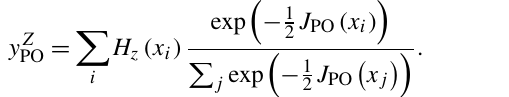
Figure 2. Bias (a) between RASTA reflectivity and the reflectivity pseudo-observation as a function of the altitude for different values of error standard deviation σ o (see legend box). Panel (b) shows the number of observations used for the calculations as a function of the altitude for the different values of error standard deviation σ o